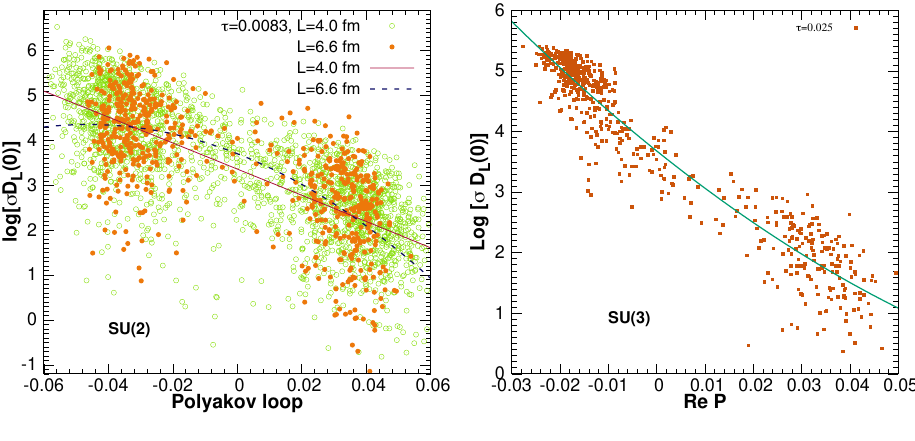
Figure 2: Scatter plots illustrating correlation between the zero-momentum longitudinal prop- agator and the Polyakov loop. On the left panel data are shown at two di ↵ erent volumes and the same temperature. Shown lines are the regression curves based on the linear model